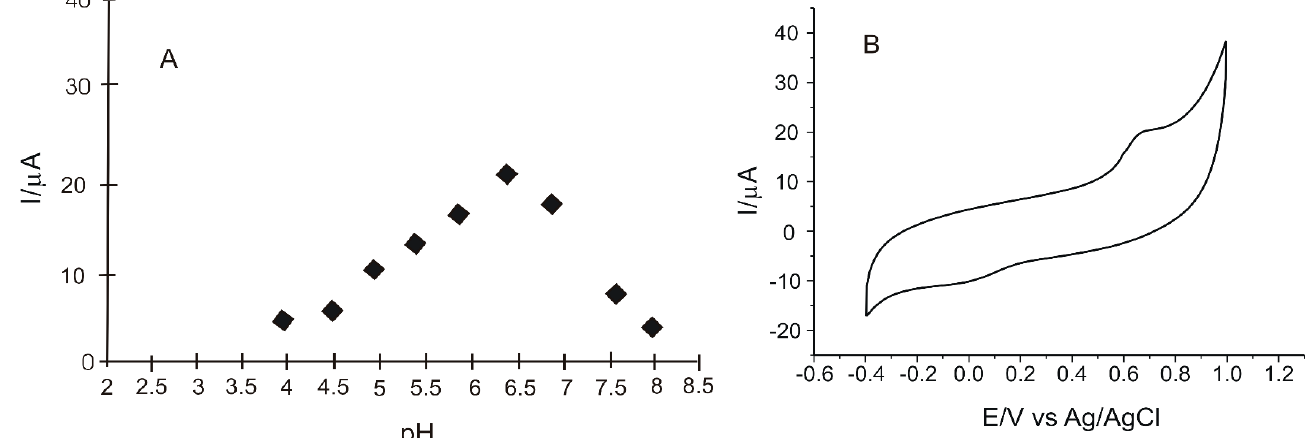
Figure 6. Influence of pH on the intensity of the anodic peak current ( A ). Cyclic voltammogram of GO-Peptide/SPCE immersed in 0.1 M PBS, pH = 6.5 ( B ).